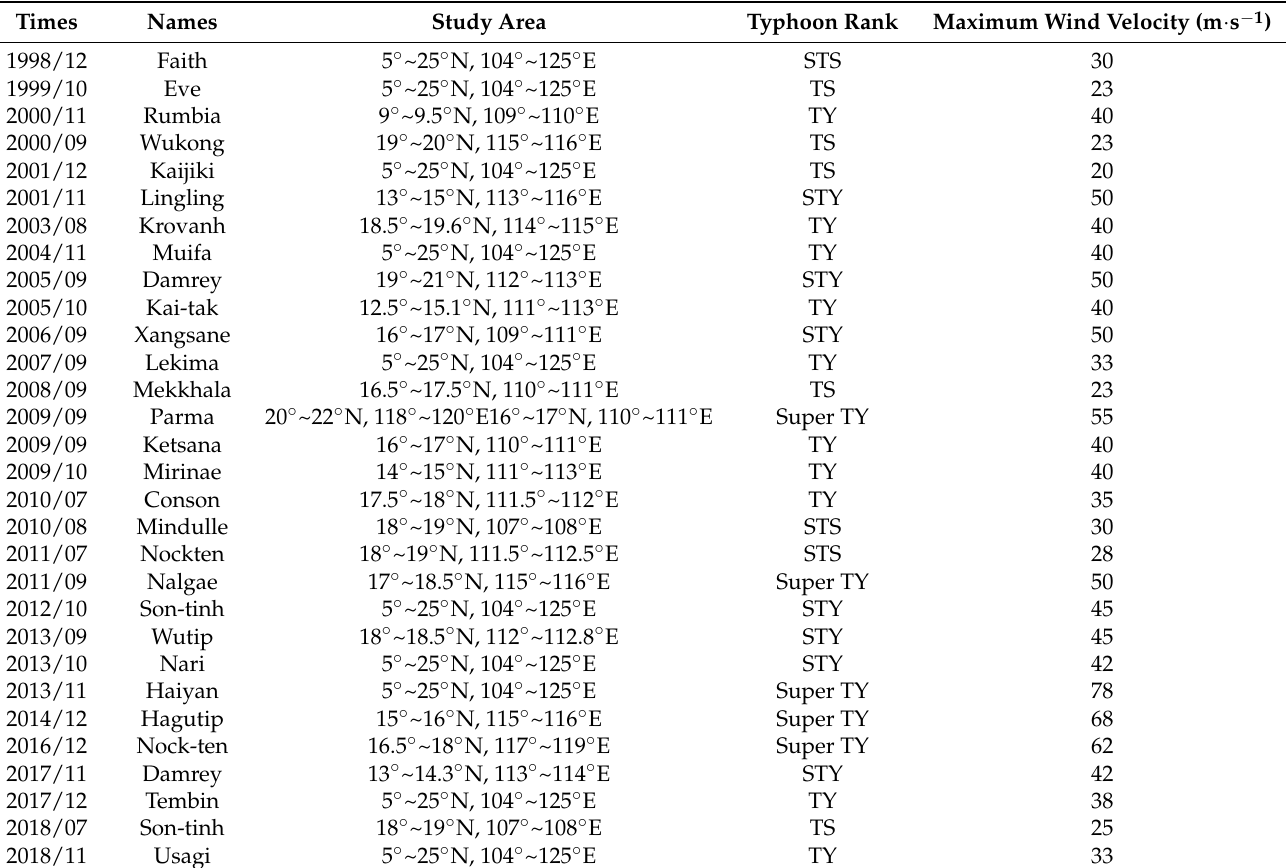
covers the world. This data set removes the influence of daytime sea surface temperature warming and the SST data of rainwater pollution, and meets the research requirements of sea surface temperature changes after the typhoon passes. The typhoon data in this study are from the tropical cyclone data center of China Meteorological Administration (Shanghai Typhoon Research Institute) http://tcdata.typhoon.gov.cn (accessed on 1 March 2021), in which the data were recorded the typhoon center location, central pressure value and maximum wind speed every 6 h [51]. Table 1. Basic information of westward typhoons passing through the South China